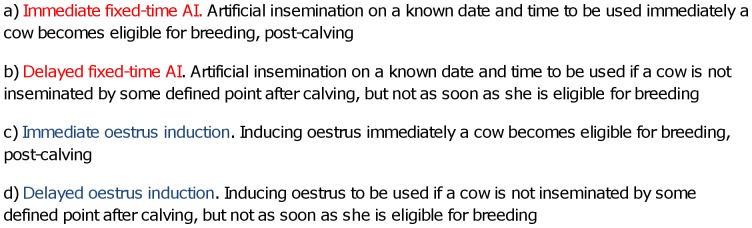
The four main ways to assist breeding in lactating dairy cattle using hormones.